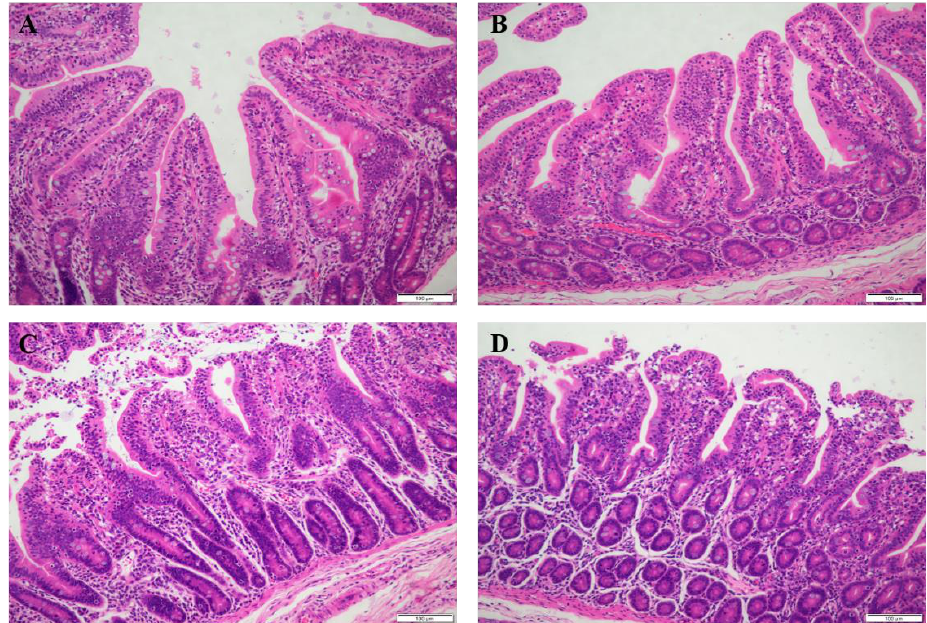
Figure 1. Jejunal mucosal histological appearance (hematoxylin and eosin) of the piglets fed polyphenols sourced from Ilex latifolia Thunb. (PIT) diets under oxidative stress. Original magnification 200×. Scale bars = 100 μm. ( A ) Piglets fed the basal diet and treated with saline. ( B ) Piglets fed the PIT diet and treated with saline. ( C ) Piglets fed the same basal diet and treated with diquat. ( D ) Piglets fed the same PIT diet and treated with diquat.